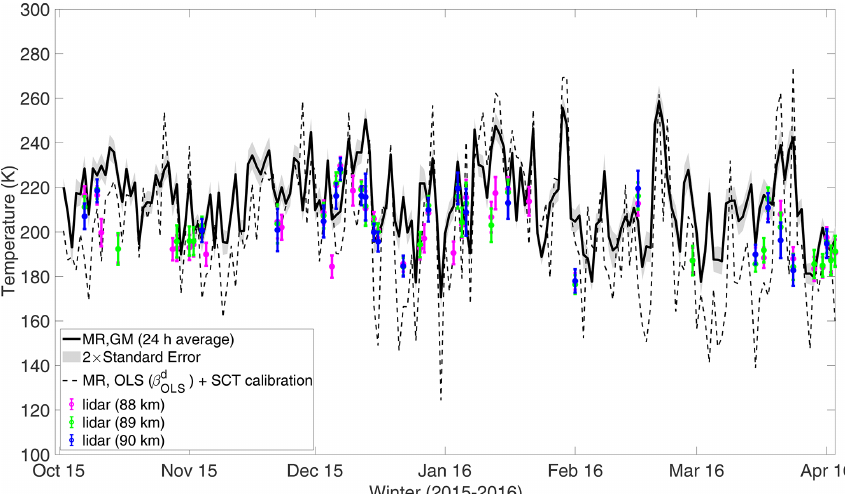
Figure 5. Comparison of the bias-corrected MR temperatures with lidar data for the winter 2015–2016. The solid line corresponds to the temperature estimated using the GM solution at contour level 0.4. The dashed line corresponds to the SCT-calibrated temperatures using the co-located lidar measurements. The OLS estimates are obtained with log 10 ( 1 /τ) as an independent variable. The errors in lidar temperatures are 5–10K, and the 2 σ error (grey shade) of the temperature from EIV analysis is on average 11K. The differences between lidar and MR temperatures are presented in Fig.